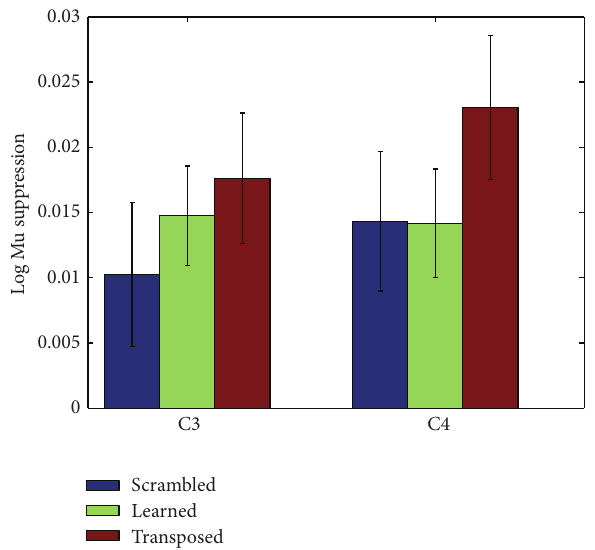
Figure 3: Mu suppression at electrodes C3 and C4. Error bars represent standard error of the